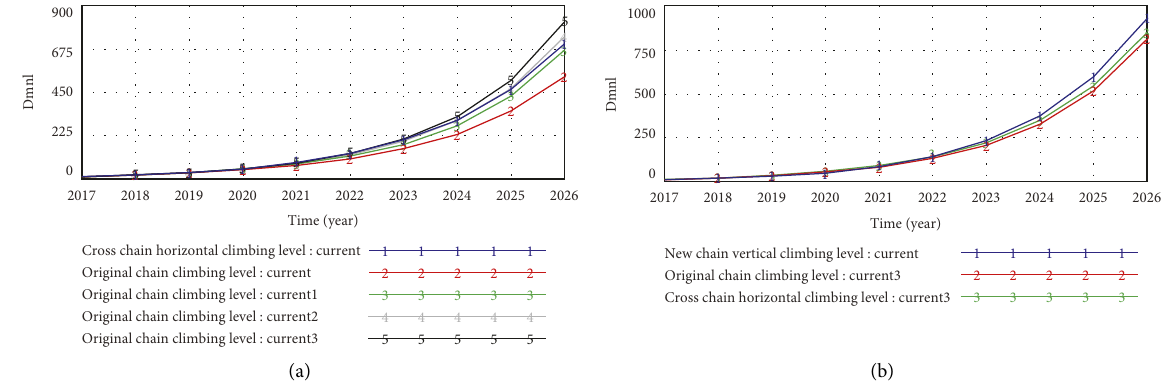
Figure 6: (a) Sensitivity analysis of technological innovation level. (b) Sensitivity analysis of technological innovation level.